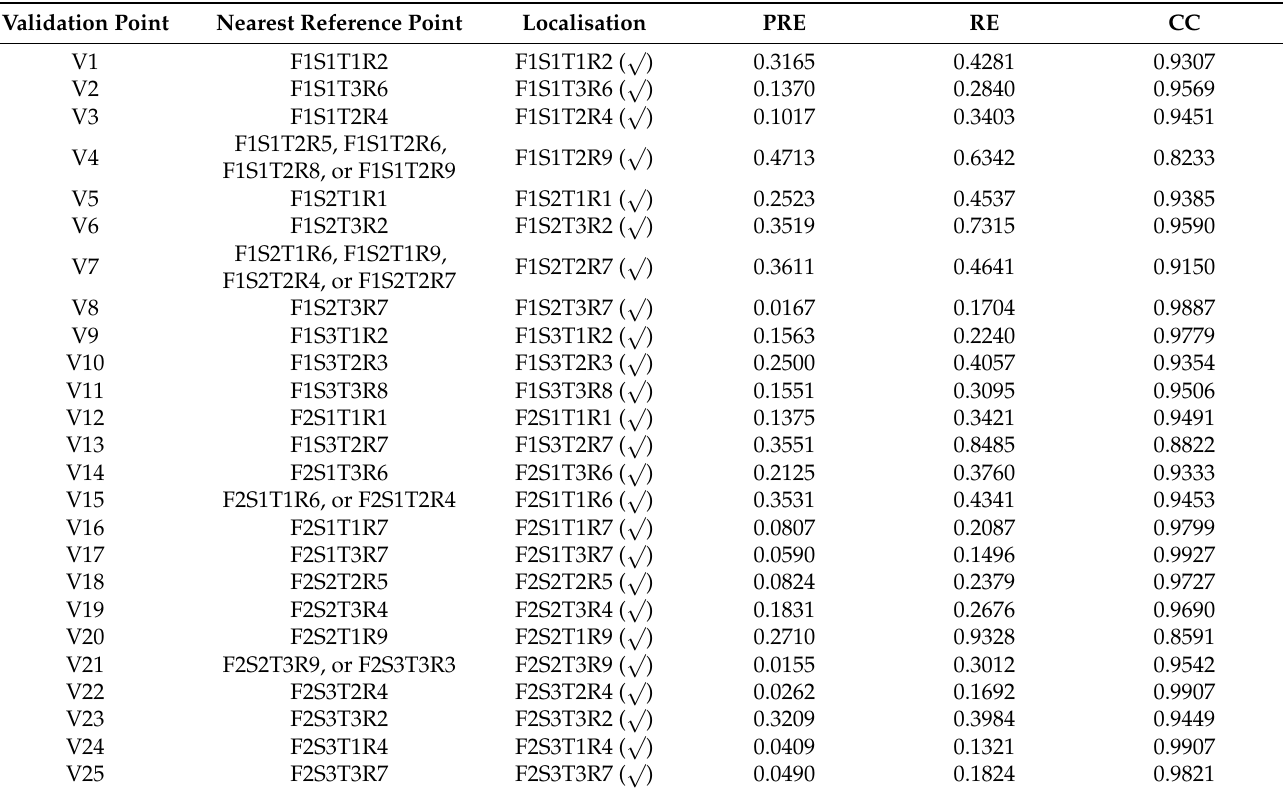
Table 2. Identification results obtained through the hybrid